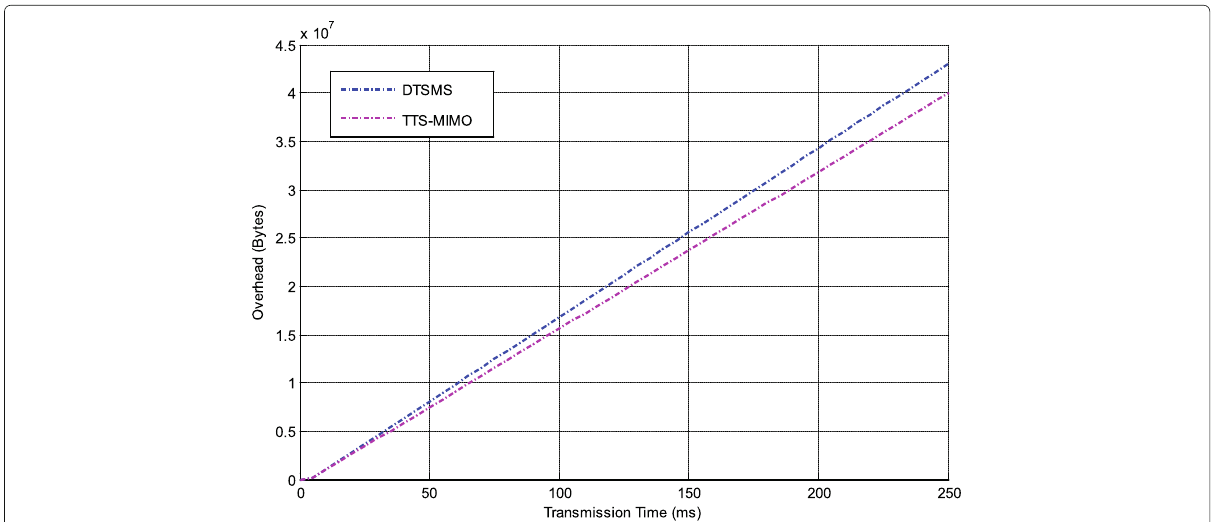
Fig. 14 Overhead in DTSMS and